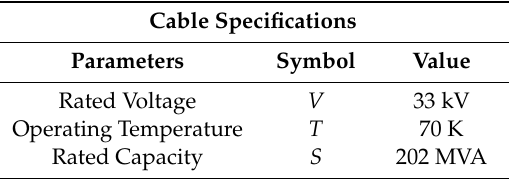
Table 4. Specifications of 33 kV SC.